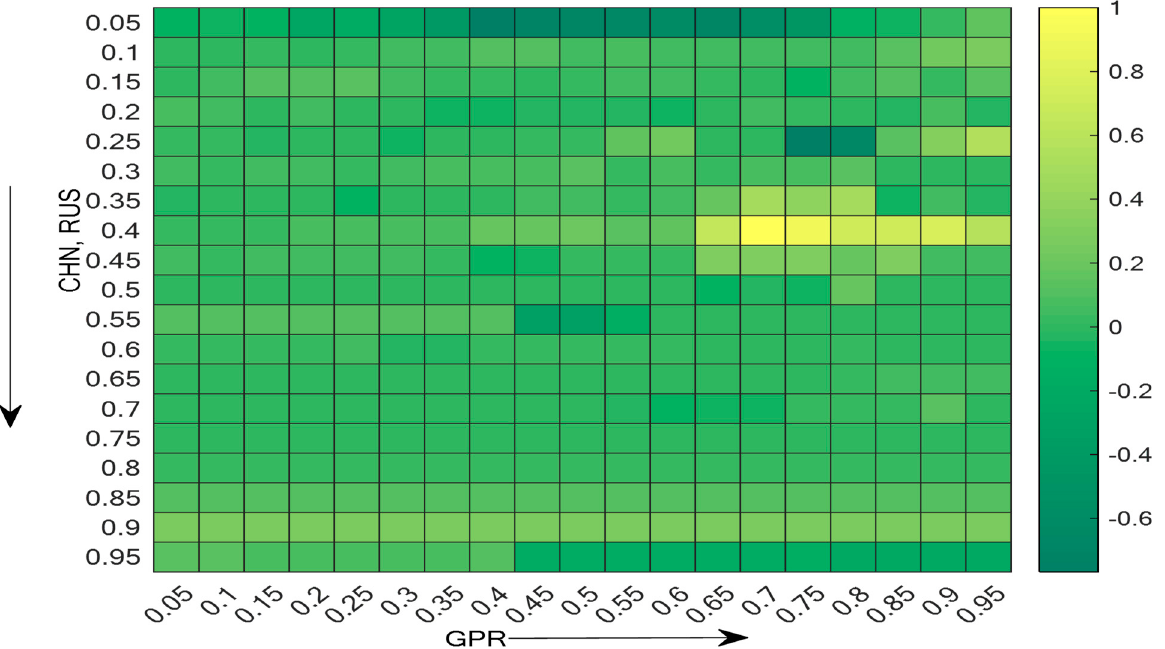
Figure 8. The response of RUS–CHN stock market synchronization to geopolitical risk. Note: The horizontal axis indicates the quantile of GPR, whereas the vertical axis is the quantile of stock market synchronization in ascending order. The right-side color bar indicates the intensity of the response of synchronization to GPR. The dark green and yellow colors indicate negative and positive responses and synchronization to GPR, respectively.